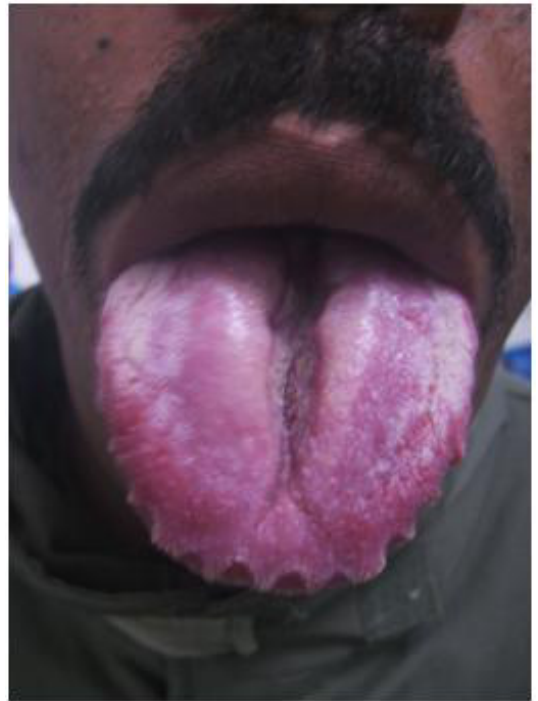
Figure 1: Macroglossia with fissured dorsal tongue (lingua plicata)